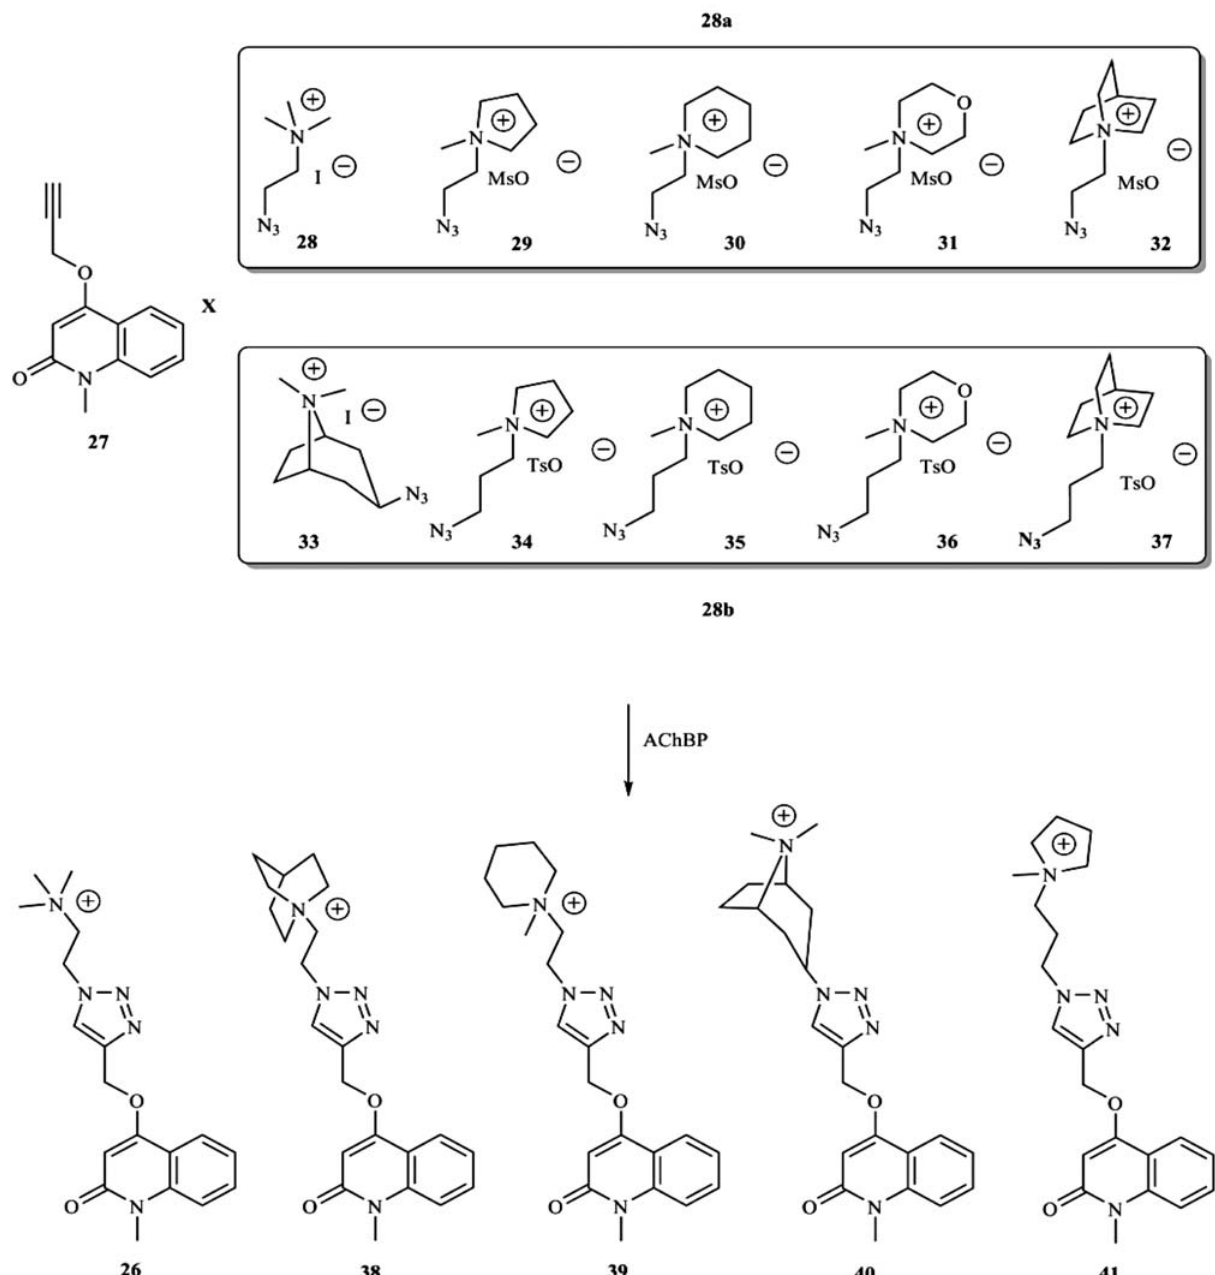
Figure 15. In situ click chemistry screening of azide libraries 28a and 28b against alkyne 27 .